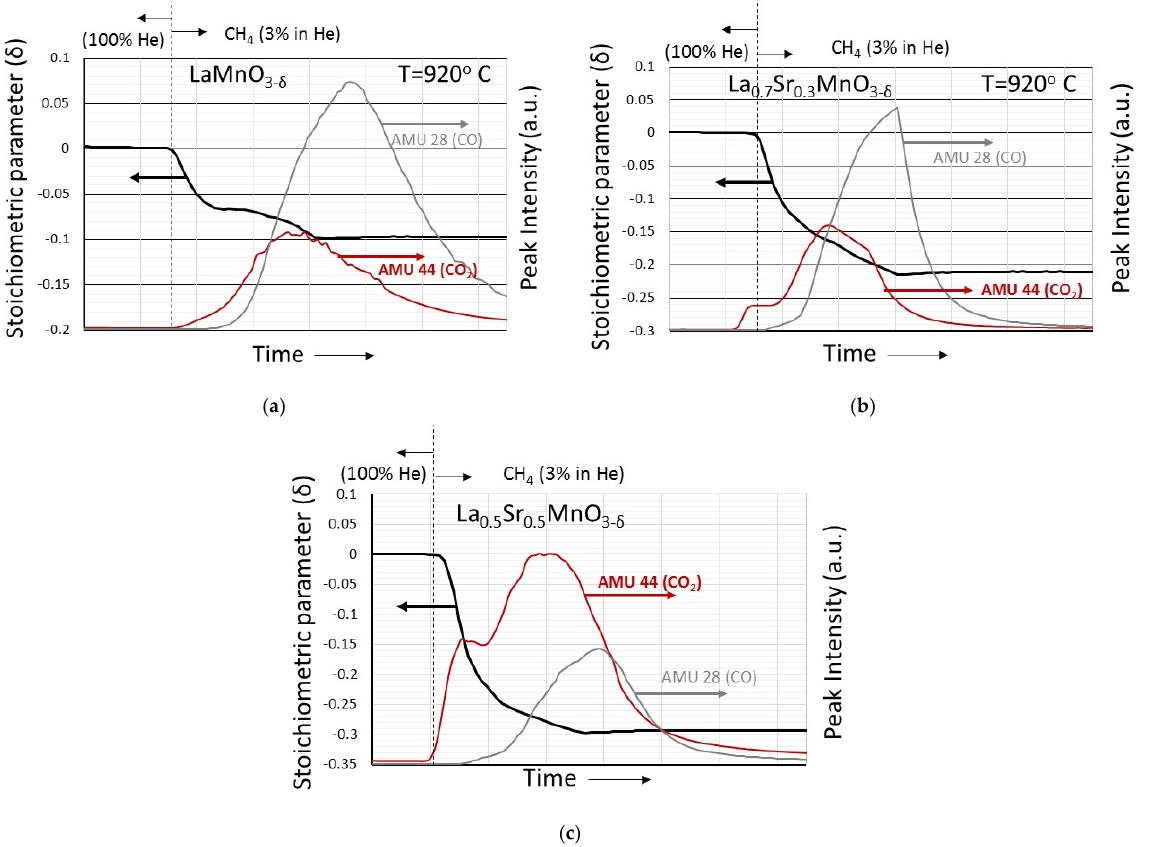
Figure 9. Evolution of CO and CO 2 characteristic mass spectrometer peaks (at Atomic Mass Units 28 and 44, respectively) that accompany the weight loss curves of ( a ) LaMnO 3- δ , ( b ) La 0.7 Sr 0.3 MnO 3- δ and ( c ) La 0.5 Sr 0.5 MnO 3- δ upon reduction with 3% CH 4 (in He) at 920 °C.